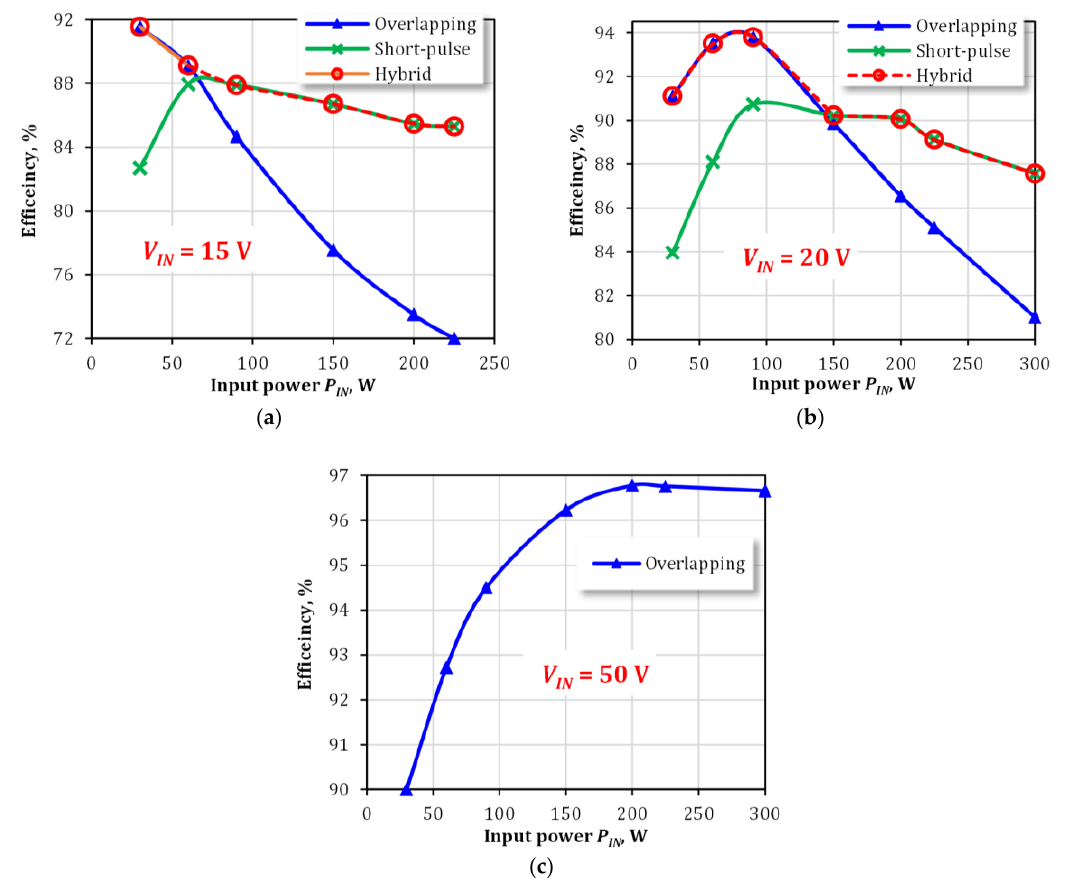
Figure 16. Experimental efficiency versus the converter power at fixed input voltages: ( a ) V IN = 15 V; ( b ) V IN = 20 V; ( c ) V IN = 50 V.